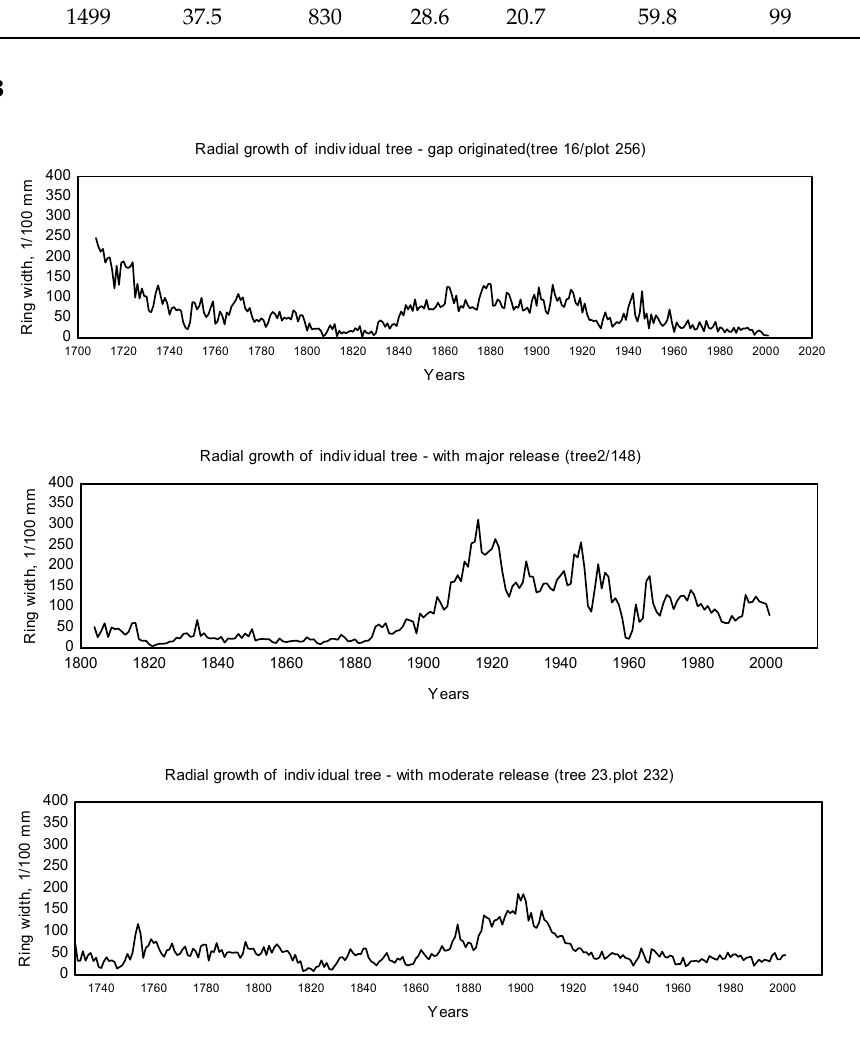
Figure A1. Radial Growth of Individual Trees: ( a ) Gap Originated, ( b ) Showing Major Release, ( c ) Showing Moderate Release.